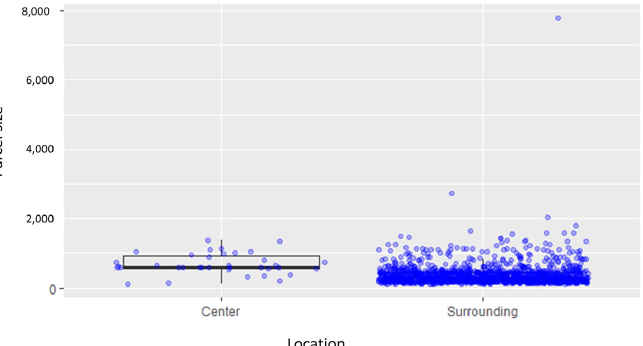
Figure 12. Land leasing urban land plot size (in square meters) distribution by their location.